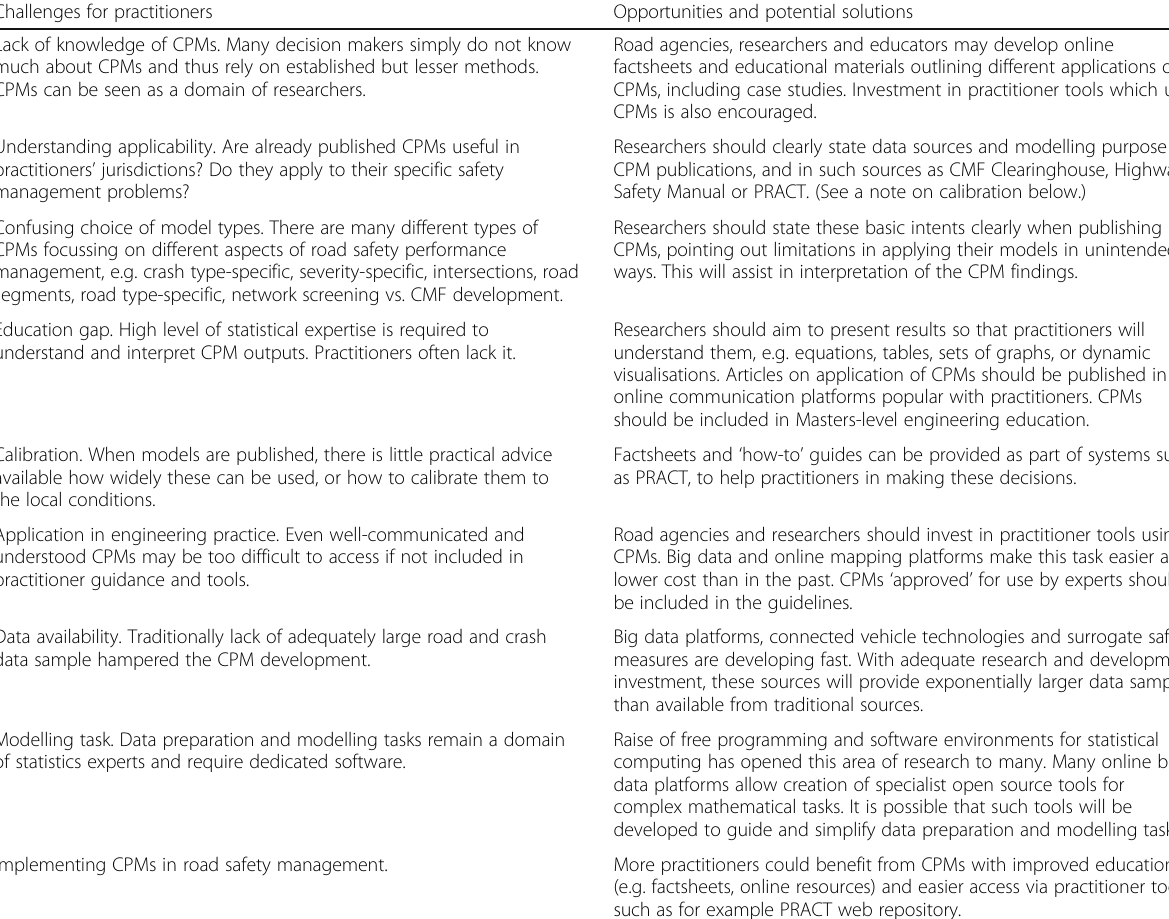
Table 1 Overview of identified challenges, opportunities and potential